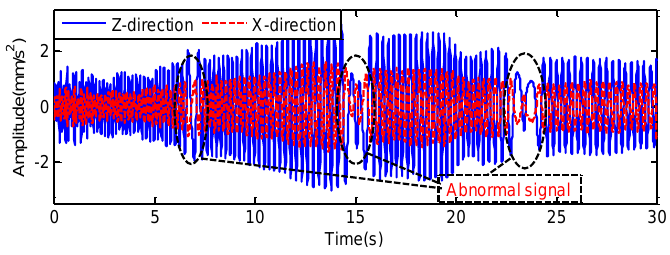
Figure 12. Newly reconstructed complex-valued signal from experimental data.